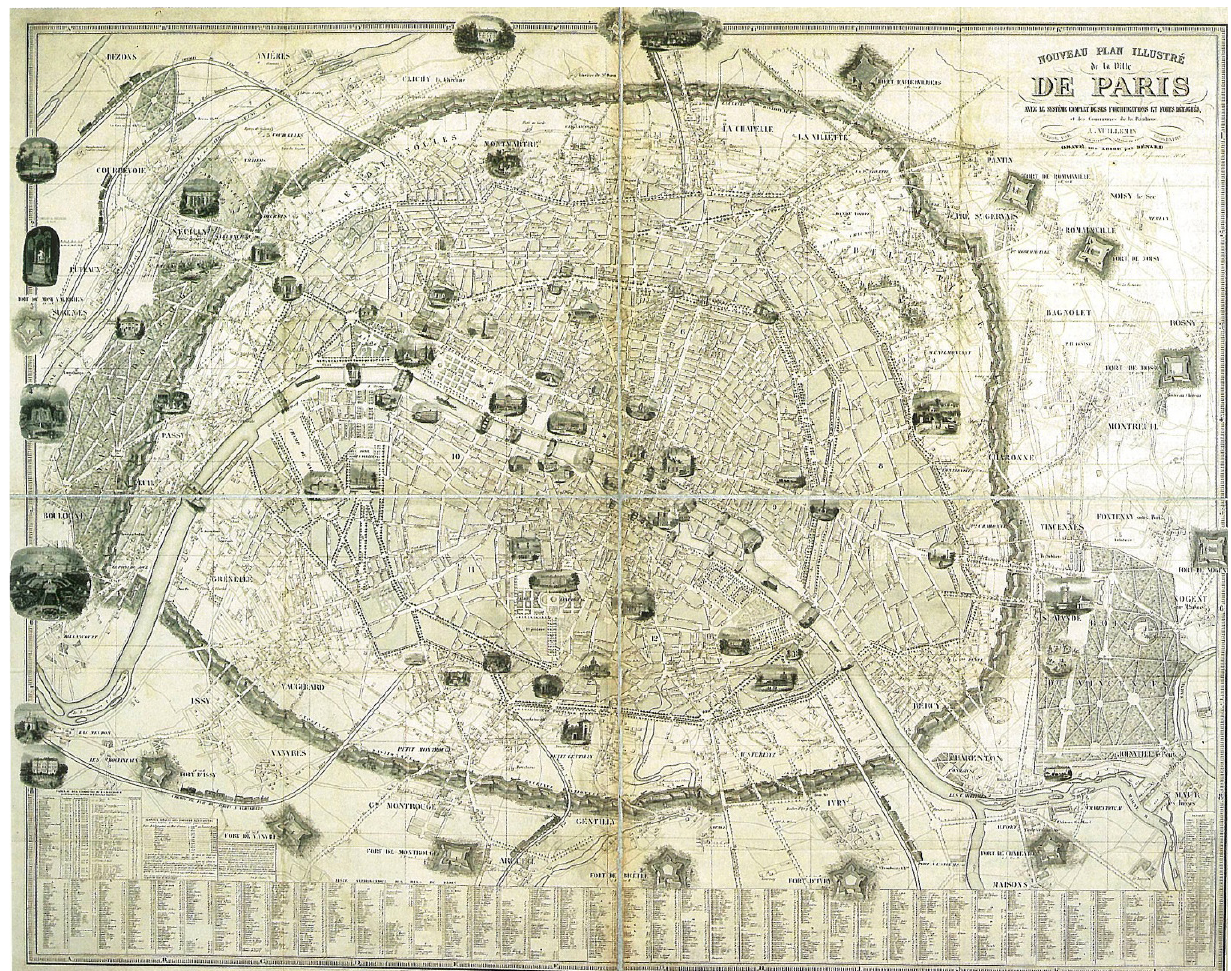
Figure 3. The new illustrated map of Paris, 1847. Source: Pinol (1996, p.